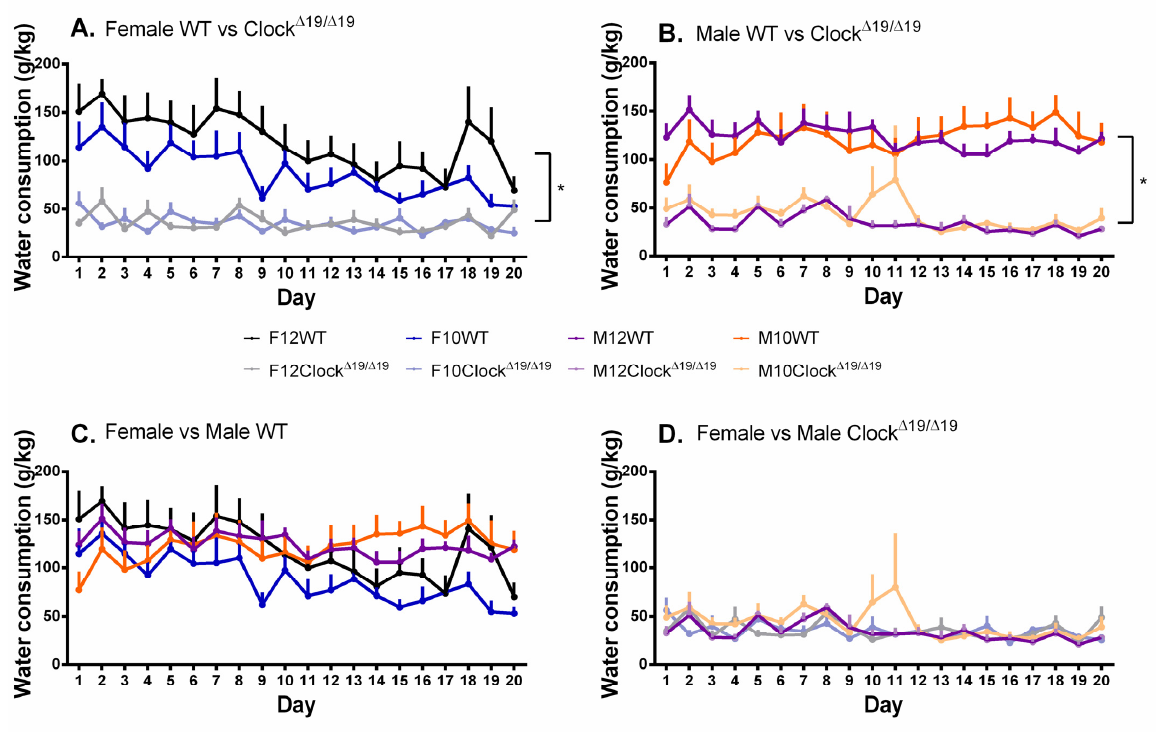
Figure 4. The amount of water consumed by mice is influenced by sex, genotype, and number of drinking days, but not L:D cycle. ( A ). Female Clock ∆ 19/ ∆ 19 mice demonstrated reduced water consumption compared to female WT mice, which demonstrated a decrease in the amount of water consumed across the 20-day testing period such that by the end of the study they were no longer different from female Clock ∆ 19/ ∆ 19 mice. ( B ). Compared to male WT mice, male Clock ∆ 19/ ∆ 19 mice demonstrated reduced amounts of water consumed, an effect that was maintained throughout the duration of the study. ( C ). Female and male WT mice initially demonstrated similar amounts of water consumed, whereas toward the end of the study the female WT mice were consuming slightly less than male WT mice. ( D ). Female and male Clock ∆ 19/ ∆ 19 mice demonstrated similar amounts of water consumed across the 20-day testing period. F = females, M = males; 12 = 12:12 L:D cycle, 10 = 10:10 L:D cycle; WT = wild-type. Darker tones are WT mice and lighter tones are Clock ∆ 19/ ∆ 19 mice. Black = female 12:12 L:D group, blue = female 10:10 L:D group, purple = male 12:12 L:D group, orange = male 10:10 L:D group. * = p <